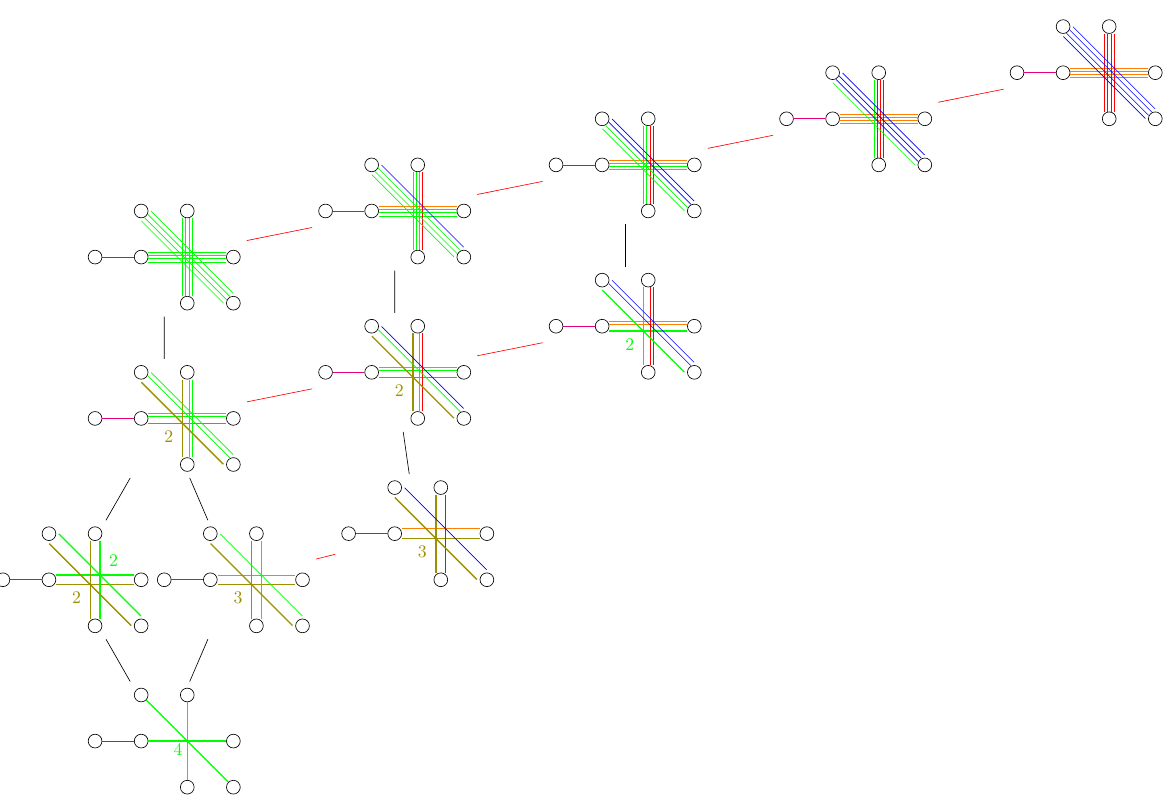
Figure 10. Brane Web Hasse diagram for 4 SU(3) instantons. The magnetic quivers read from each subweb decomposition following the rules in appendix C match those in figure 7. The coloured numbers n denote the number of merged subwebs, corresponding to U(1) nodes of shortness 1 /n in the magnetic